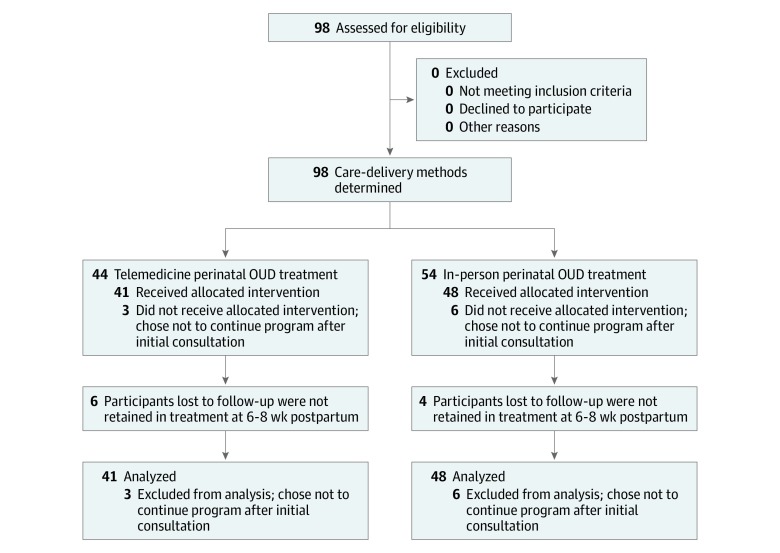
Flow Diagram of Study ParticipantsOUD indicates opioid use disorder.